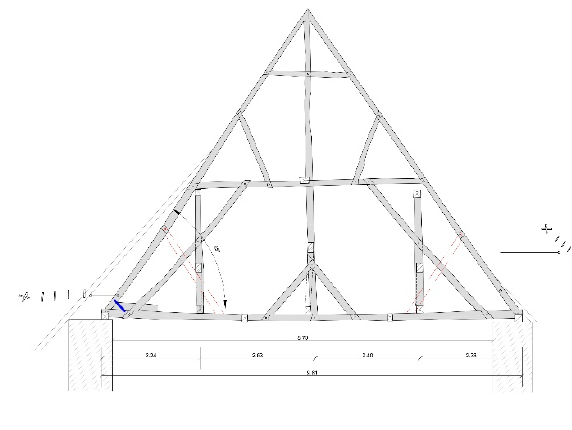
Figure 4. Survey with a total station of a principle rafter truss, truss of nave, fortified church, Arbegen, Transylvania © Brunner, Malik, Staudinger 2014